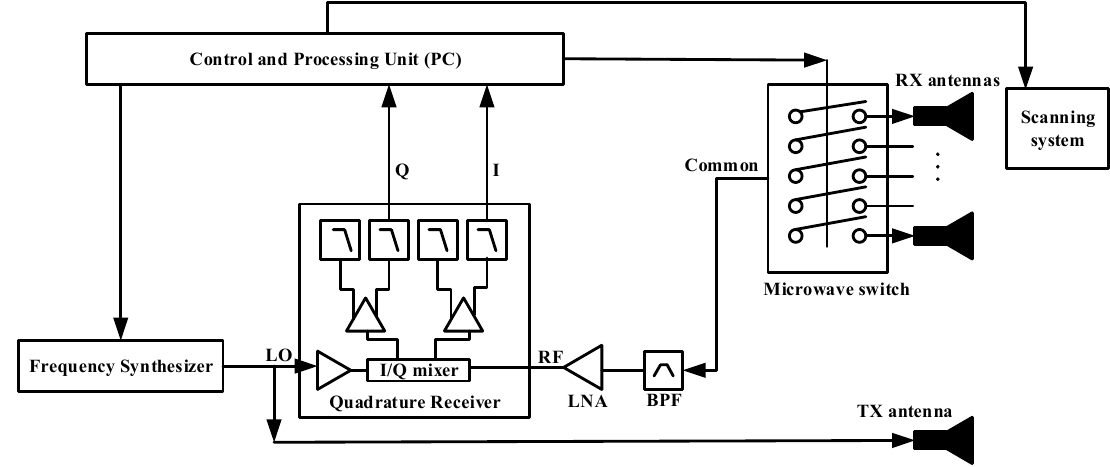
Figure 14. Block diagram of the imaging system.